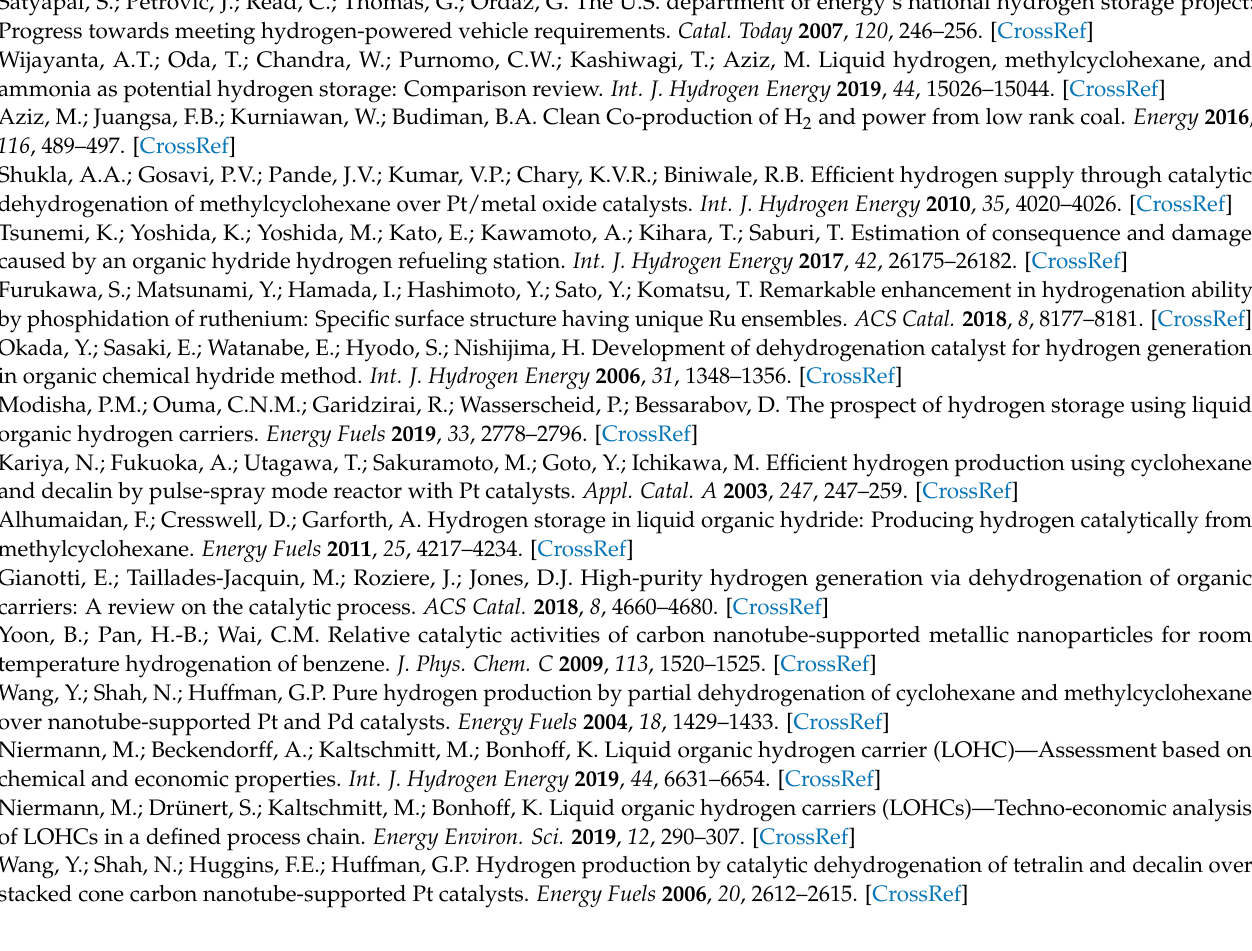
nanoparticles for ( a ) Pt 3 Rh/C, ( b ) Pt 3 Au/C, ( c ) Pt 3 Pd/C, ( d ) Pt 3 Ir/C, ( e ) Pt 3 Cu/C and ( f ) Pt 3 Ni/C catalysts. Figure S3: Pt4f and Rh3d, Au4f, Pd3d, Ir4f, Cu2p or Ni2p core level spectra for ( a ) Pt 3 Rh/C, ( b ) Pt 3 Au/C, ( c ) Pt 3 Pd/C, ( d ) Pt 3 Ir/C, ( e ) Pt 3 Cu/C and ( f ) Pt 3 Ni/C catalysts after the LSV measurement, Figure S4: XRD patterns of Pt 3 M/C (M = Rh, Au, Pd, Ir, Cu and Ni) catalysts after the LSV